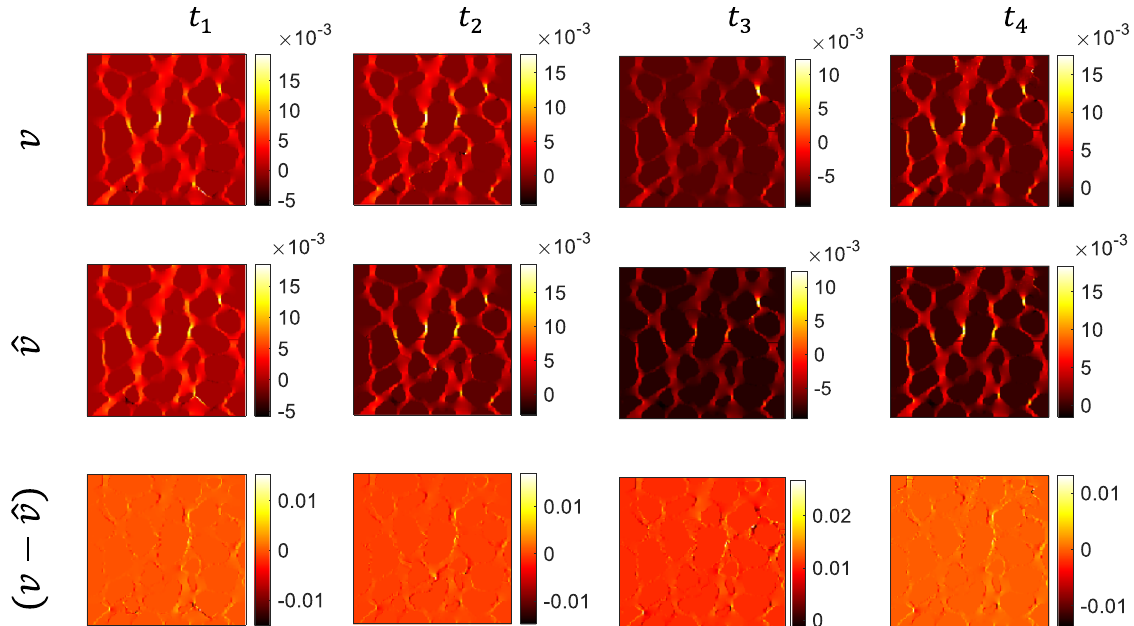
Fig. 9 PIRED predictions for the fl uid velocity in the sandstone. Comparison of the predicted fl uid velocities v with the numerically calculated values ^ v at four times.